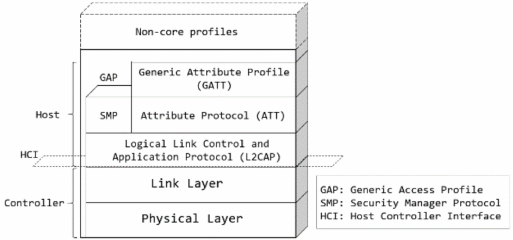
Figure 1. BLE protocol stack